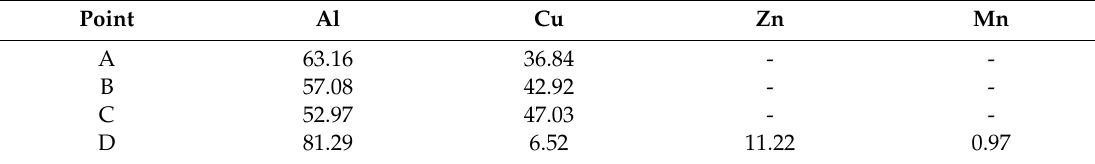
Table 3. EDS results of chemical compositions (at.%) of points marked in Figure